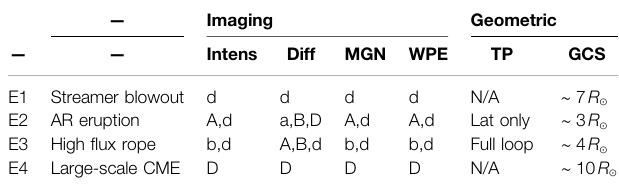
TABLE 1 | Results from applying different imaging and geometric techniques to the events under study. For the imaging techniques, the observed eruption signatures are indicated, with A (cid:2) arcade, B (cid:2) brightening, and D (cid:2) dimming. The upper cases denote strong signatures, while the lower cases denote only weak signatures. For the geometric techniques, it is indicated whether the TP method could be applied (N/A for events that only had one off-limb view available) and which features could be triangulated, as well as the radial distance from the Sun of the CME apex at which the earliest meaningful GCS reconstruction could be performed. The “ latitude projection ” scheme could in principlebeappliedtoalleventsunderstudy,sinceitonlyrequiresoneoff-limb viewpoint of the eruption, hence it is not shown